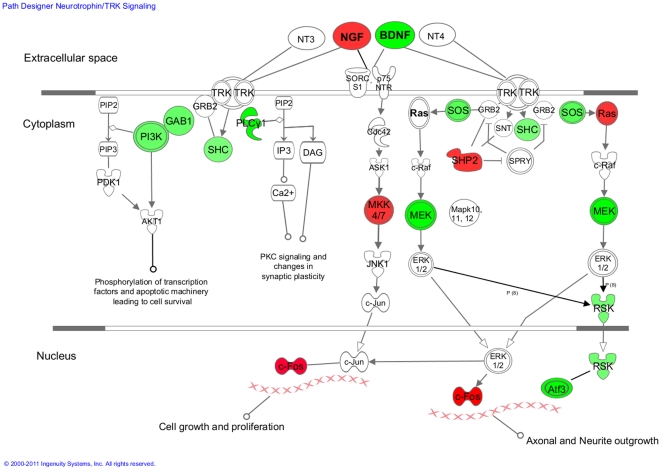
Schematic depiction of the neurotrophin signaling pathway.Those gene indicated in red represent genes upregulated in expression and those in green, downregulated in expression, in response to Bcl11b. Figure generated using Pathway Design by Ingenuity Systems Pathways Analysis. Abbreviations for the official gene symbols as follows: BDNF, Bdnf; NGF, Ngfb; PI3K, Pik3r1; GAB1, Gabl1; SHC, Shc1; PLCγ1, Plcg2; Ras, Kras; SOS, Sos1; SHP2, Ptpn11; MKK4/7, Map2k7; MEK, Map2k1; RSK, Rps6ka1; c-fos, Fos; Atf3, Atf3.